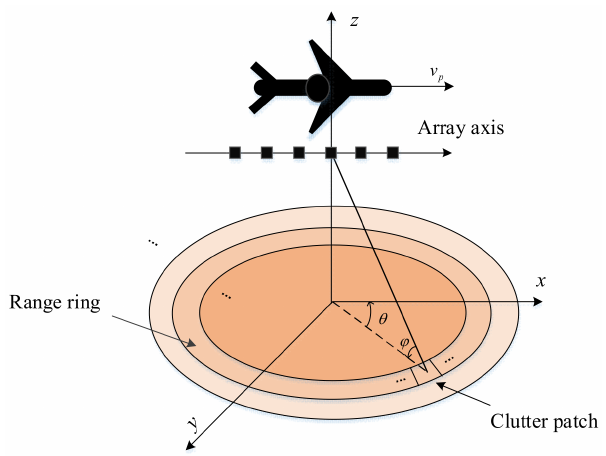
Figure 1. Geometric configuration of an airborne surveillance